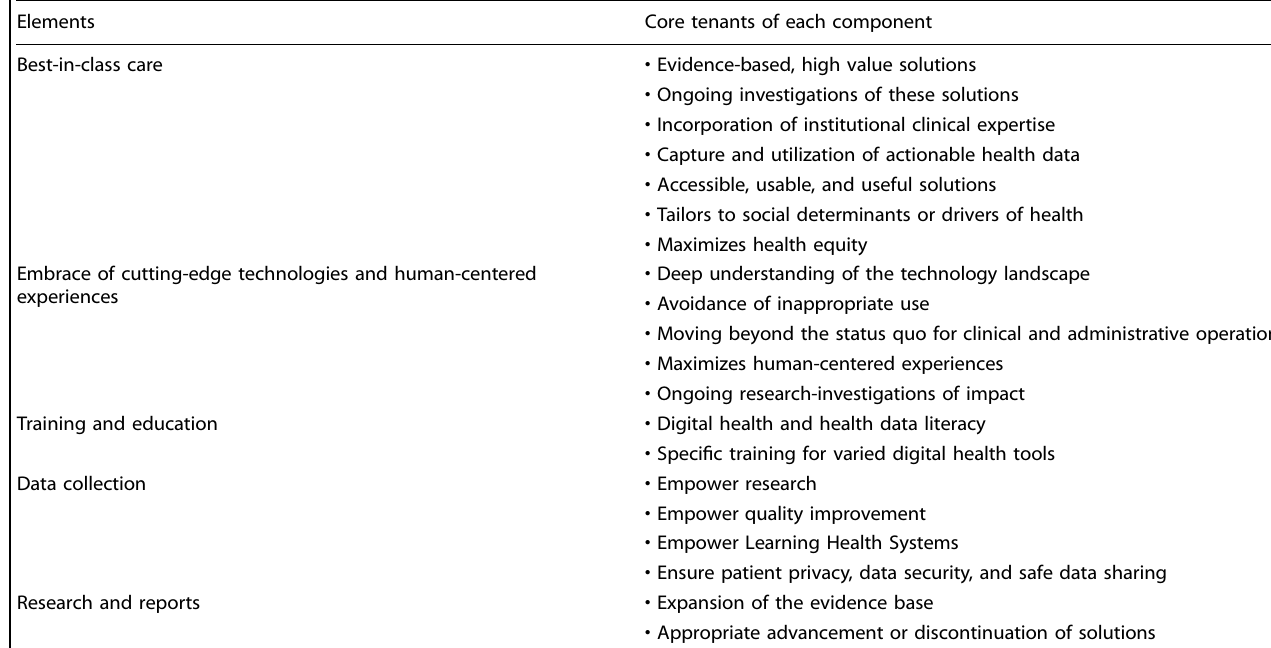
Table 1. Key components of a mission-aligned digital health strategy for academic health centers, which span clinical, patient experience, research, education, and training